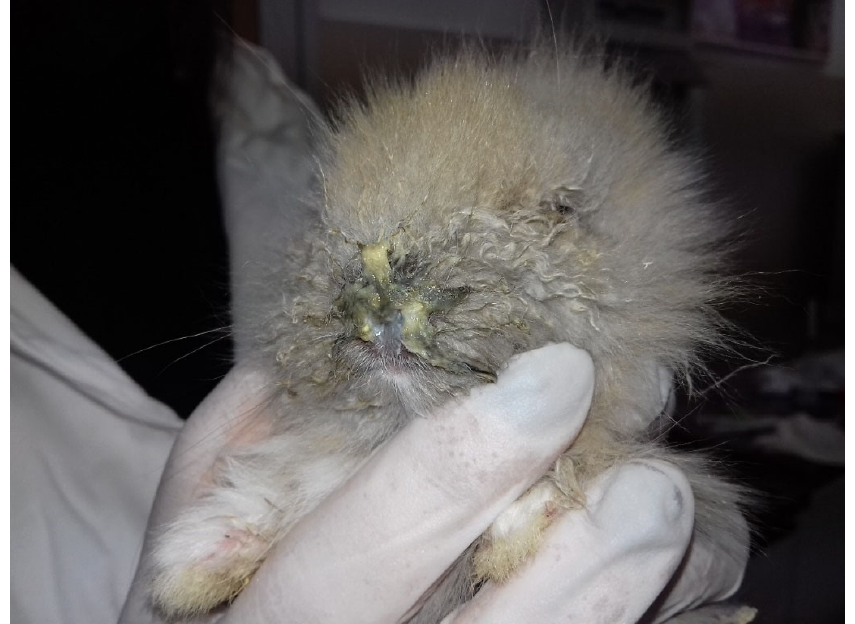
Figure 3. Bunny with severe purulent rhinitis.